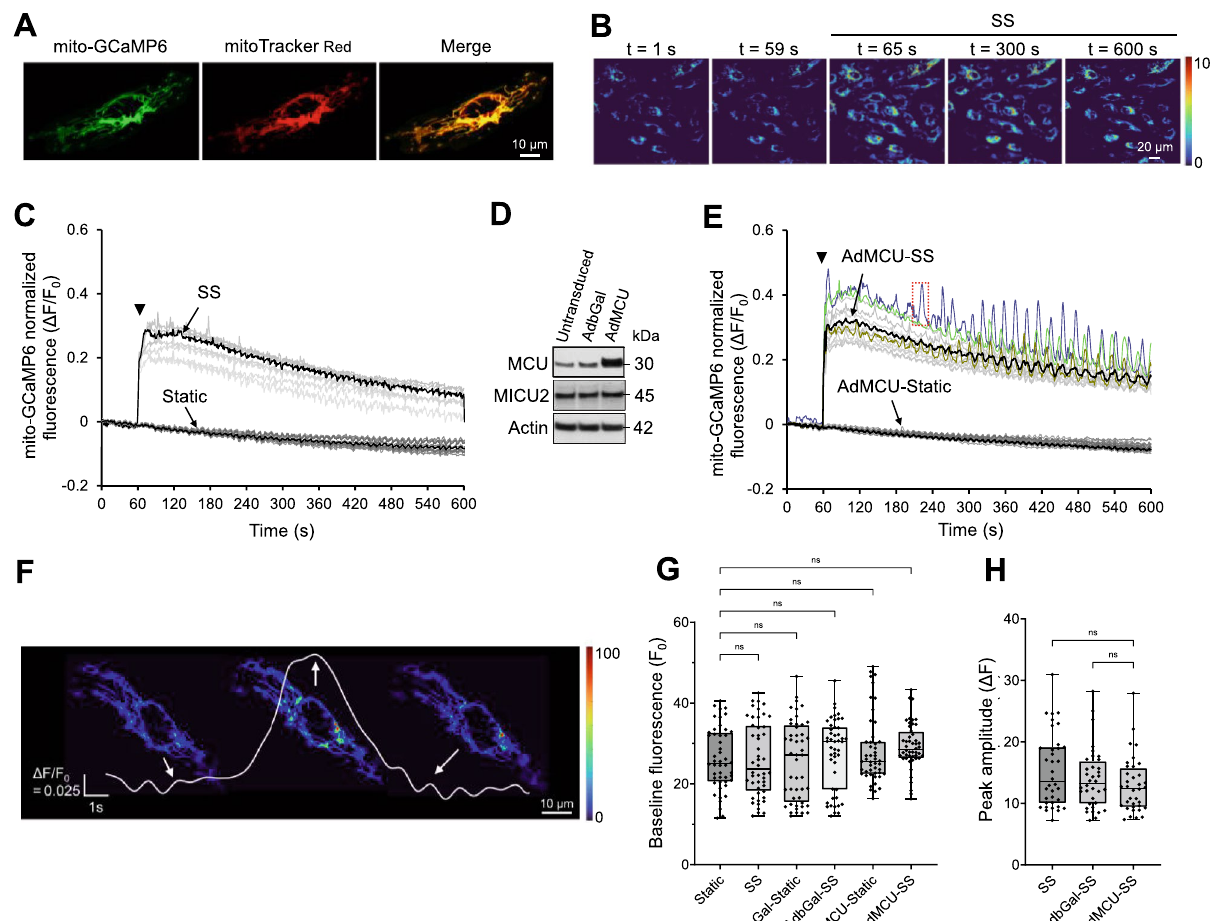
Figure 1. MCU OX causes [Ca 2+ ] m transients/oscillations in sheared HUVECs. ( A ) A characteristic fluorescence image of mito-GCaMP6 shows overlap with the mitochondrial network, identified by mitoTracker Red, in an EC. ( B ) Characteristic mito-GCaMP6 microscope images of an EC monolayer at different times, while exposed to 1 min static followed by 9 min of SS. ( C ) Characteristic temporal profiles of normalized mito-GCaMP6 fluorescence for each EC in a microscope field of view, while exposed to either static incubation for 10 min (Static) or 1 min static incubation followed by 9 min of SS (SS). ( D ) A characteristic Western blot of lysates from untransduced, Ad.βGal- or Ad.MCU-transduced (all static) ECs against MCU, MICU2, and β-actin. Original/uncropped blots are presented in Supplementary Fig. 1 (15 µg total protein per lane). ( E ) Same as in ( C ), but for Ad.MCU-transduced ECs. ( F ) Magnification of a [Ca 2+ ] m transient (dotted box in E ). ( G ) Box plots of baseline fluorescence (F 0 ) in arbitrary units and ( H ) of peak amplitude (ΔF) were plotted and statistically analyzed for 60 ECs (cells were from n = 4 independent experiments) in each condition tested; ns, P >